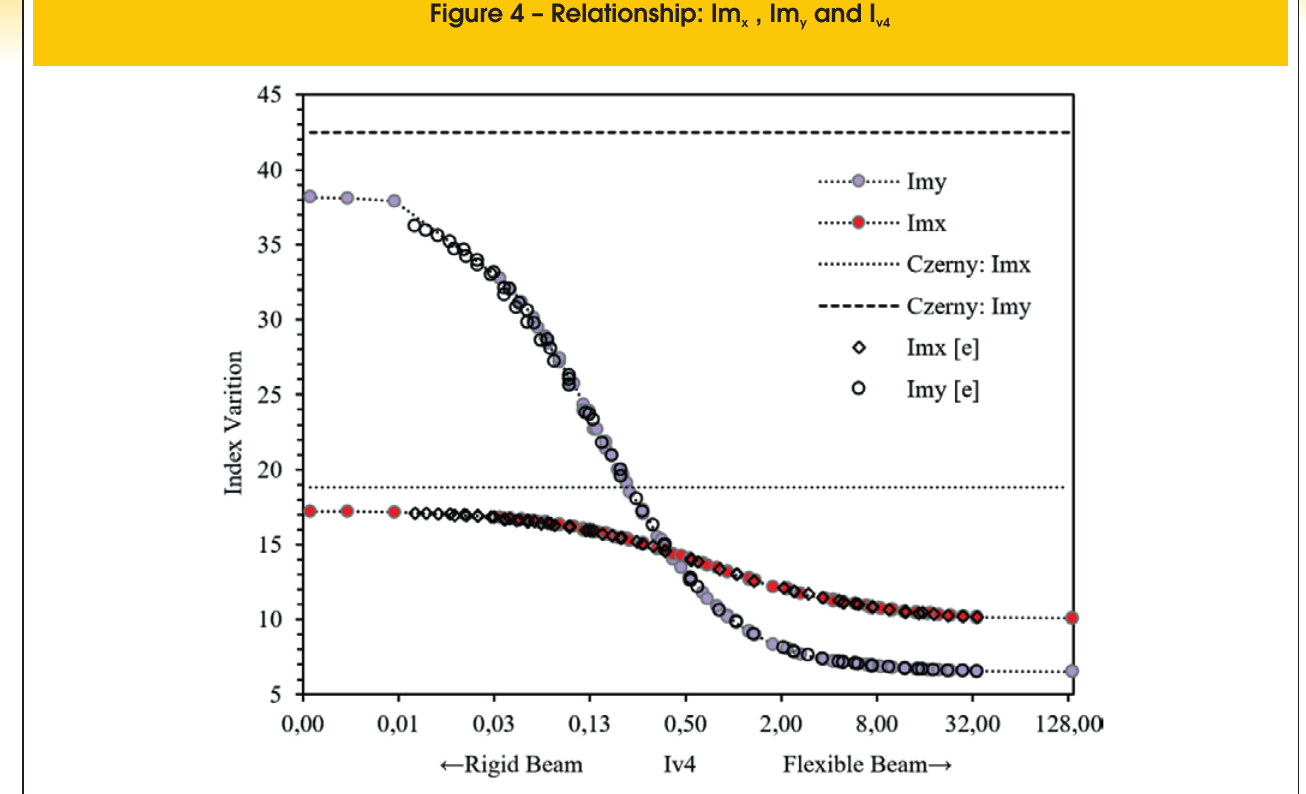
Figure 4 – Relationship: Im , Im and I